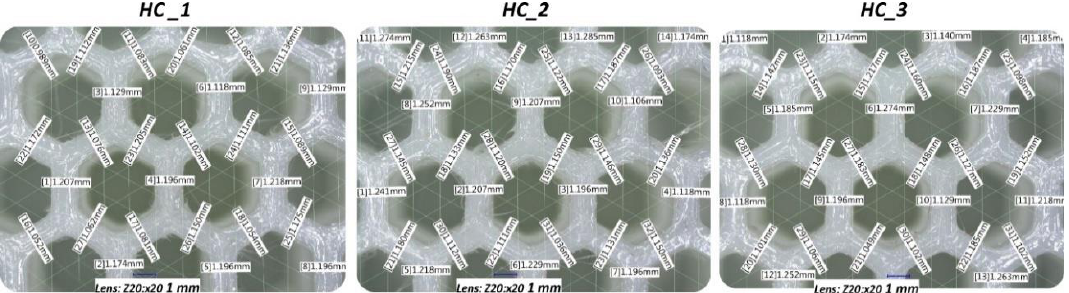
Figure 10. The results of honeycomb topology wall thickness measurements.